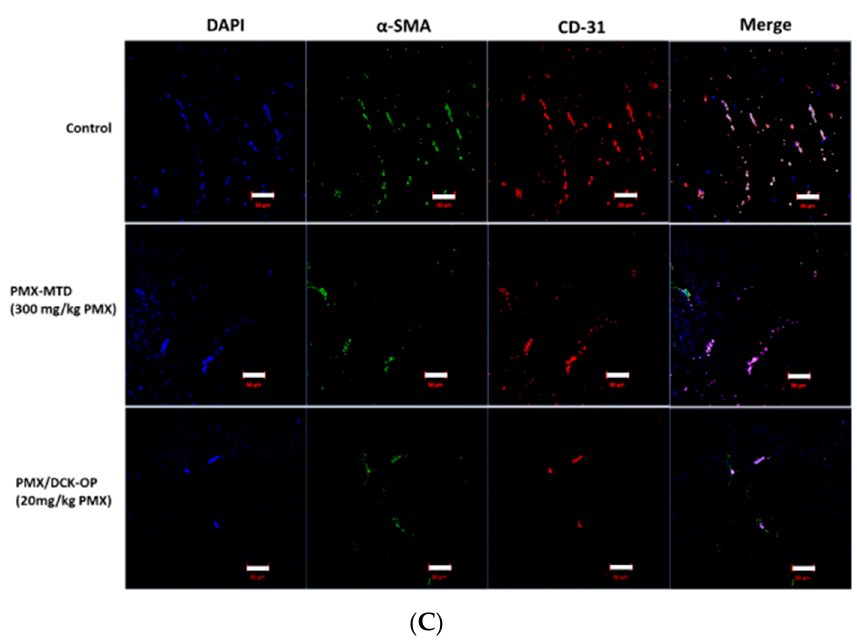
Figure 8. Anti-angiogenic effect of oral metronomic PMX/DCK-OP. ( A ) Quantification of circulating thrombospondin-1 (TSP-1) levels by ELISA in blood plasma withdrawn on the last day of the experiment from mice with A549 xenografts receiving saline (control), intraperitoneally injected PMX at 300 mg/kg/week (MTD), and oral PMX/DCK-OP (20 mg/kg/day of PMX). Data are expressed as means ± SEMs ( n = 6 per group). *** p < 0.001 compared to the control. ## p < 0.01 compared to the PMX-MTD (300 mg/kg PMX) group. ( B ) Immunofluorescence analysis of TSP-1 release from tumor tissues isolated on the last day of the experiment from A549 xenografts ( n = 3). Magnification 800×. Bar: 20 µm. ( C ) Immunofluorescence analysis of blood vessel formation in tumor tissues isolated on the last day of the experiment from A549 xenografts ( n = 3). The tissues were treated with DAPI (blue), an anti-CD-31 antibody (red), and alpha SMA (green); to stain the nucleus, blood vessels, and pericytes, respectively. Magnification 200×. Bar: 50 µm.